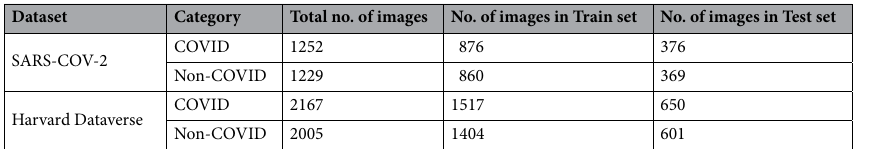
Table 1. Distribution of images in the two datasets used in the present